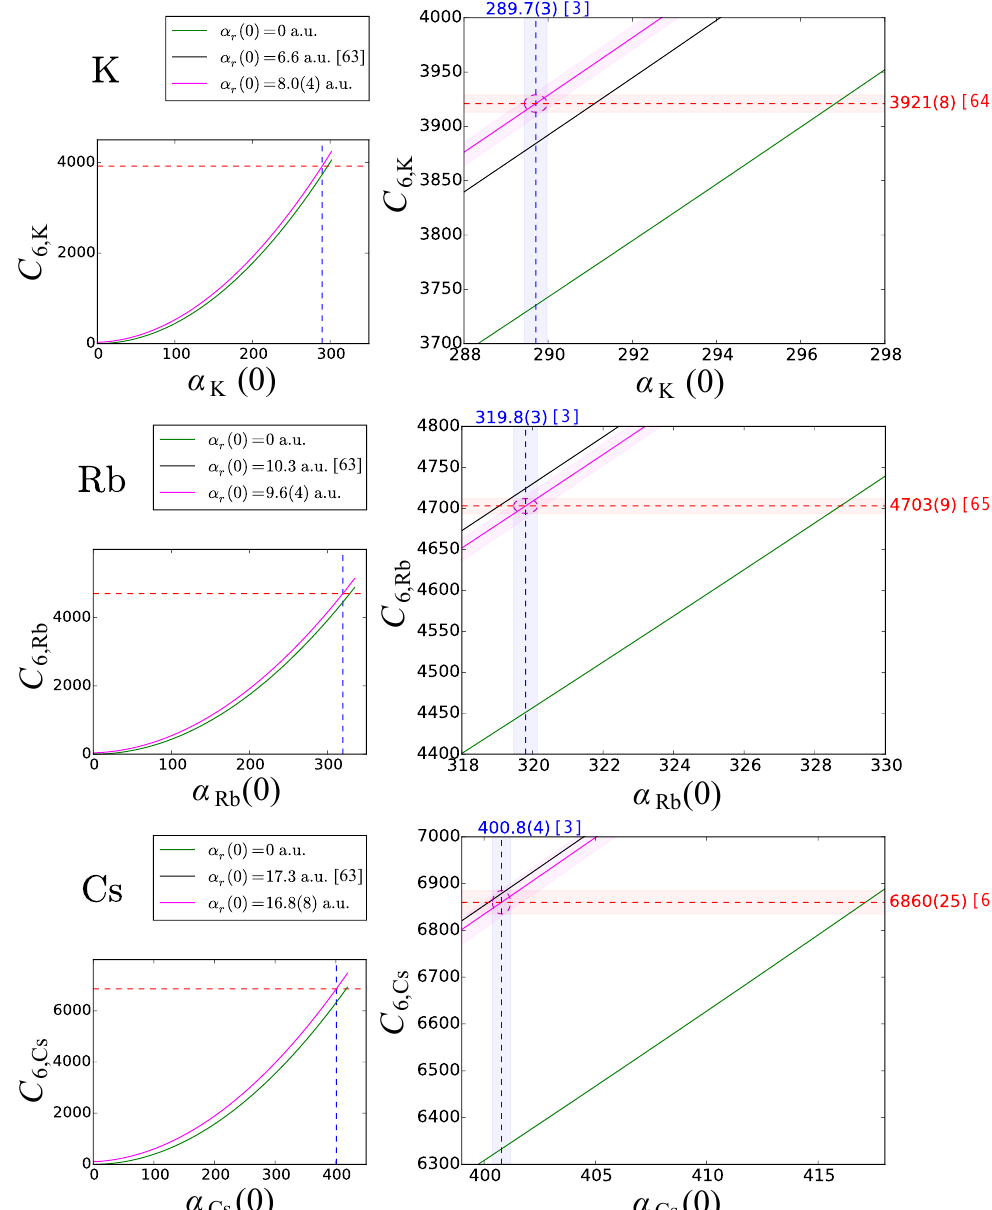
Figure 8. C 6 vs. α ( 0 ) for small deviations about experimental values of α ( 0 ) [3]. The different curves correspond to different values of α r ( 0 ) : The pink curve corresponds to the value of α r ( 0 ) inferred from experimental measurements of C 6 and α ( 0 ) [3], and the error bands on that curve represent the resulting uncertainty in α r ( 0 ) due to uncertainty in C 6 and α ( 0 ) . The black curve corresponds to the values of α ( i ω ) tabulated by Derevianko et al. [63]. Finally, the green line corresponds to α r ( 0 ) = 0, and the inset on each plot shows C 6 versus α ( 0 ) for a wider range of α ( 0 ) . For these plots, we used the C 6,K measurement by D’Errico et al. [64], C 6,Rb by van Kempen et al. [65], and C 6,Cs by Chin et al. [66]. In the smaller plots, we can see that C 6 vs. α ( 0 ) is approximately